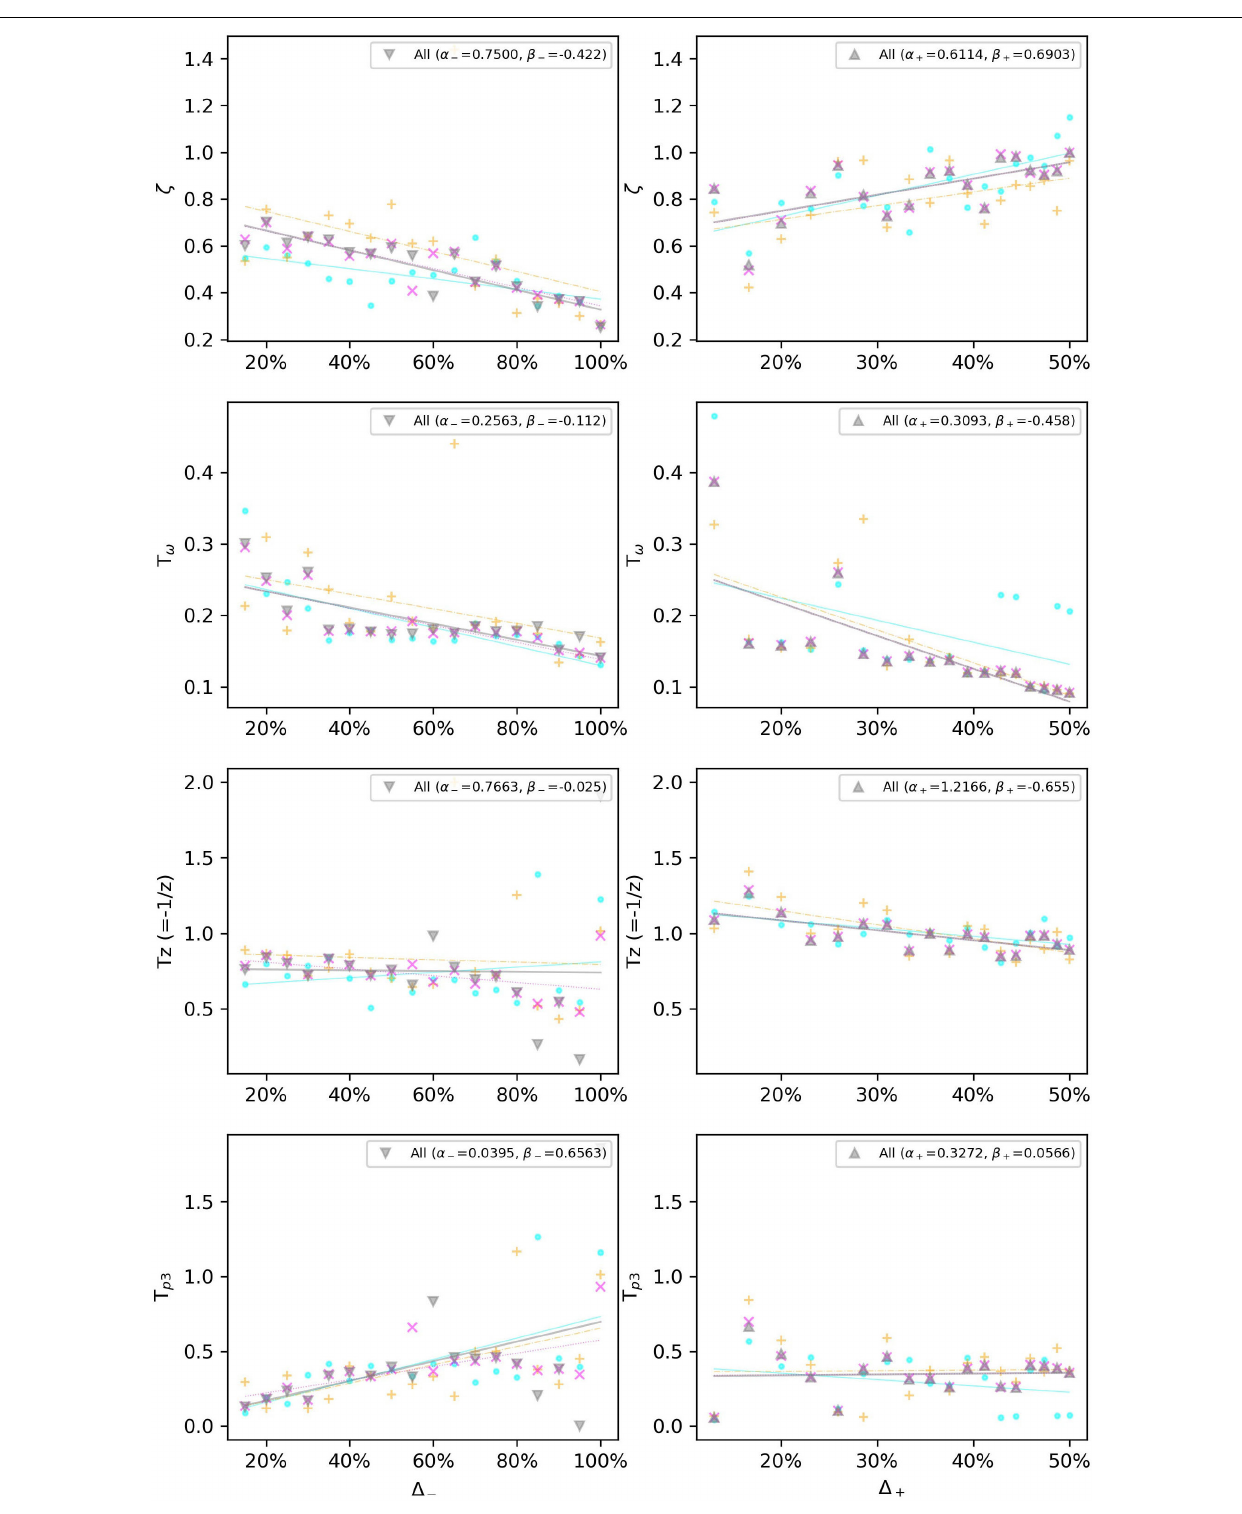
FIGURE 9 | Linear regression estimates the observed values of the P3DUZ model parameters, i.e., delay ( T D ), damping ratio ( ζ ), oscillation period ( T ω ), zero (–1/ T Z ), and the third pole (–1/ T p 3 ), for negative (up to 100% increase in tempo) and positive step sizes (up to 50% decrease in tempo) in the supraliminal range (base tempo = 100